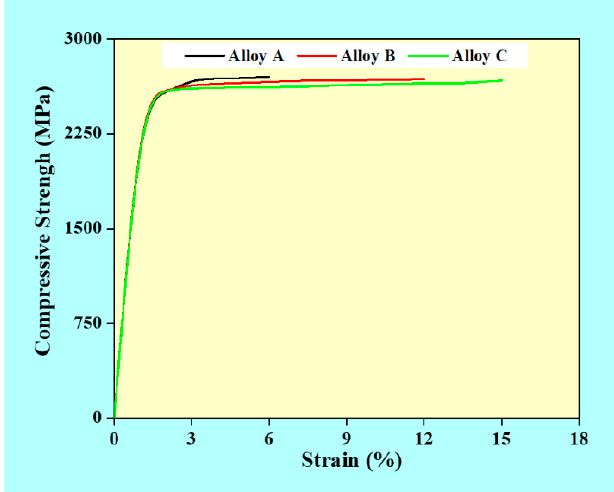
Figure 7. Compressive stress-strain curve of the consolidated oxide dispersion strengthened alloys (Alloy A, Alloy B, and Alloy C).